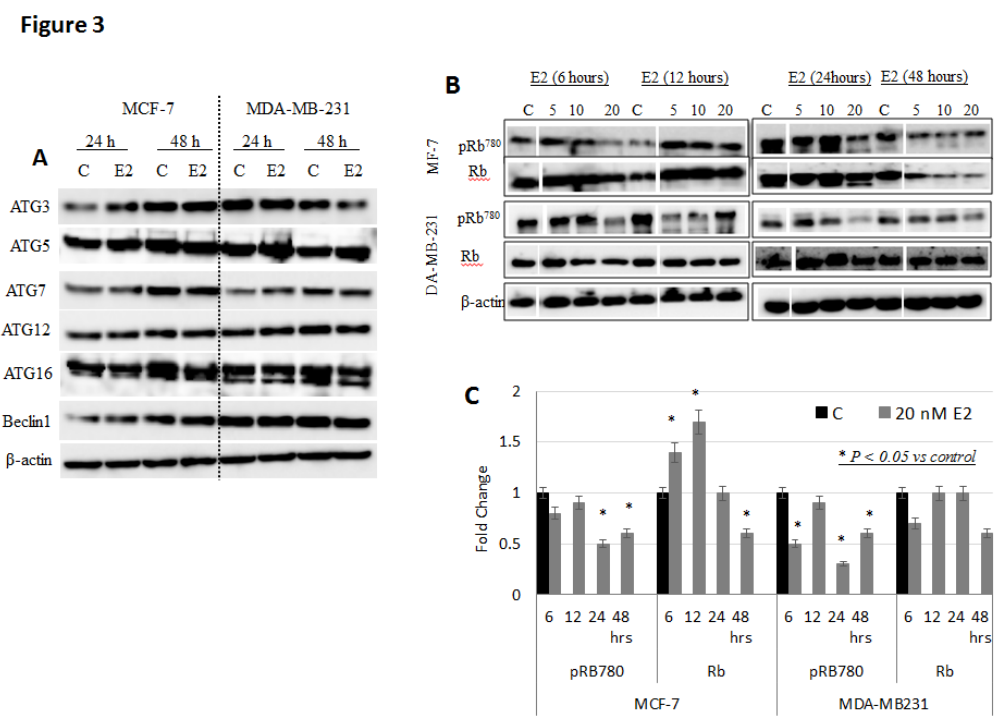
Figure 3. Expression pattern of autophagy-, cell cycle- and senescence-associated proteins in E2-treated MCF-7 cells. ( A ) Expression of autophagy related proteins ATG3, ATG5, ATG7, ATG12, ATG16, and Beclin1 in MCF-7 and MDA-MB-231 cells treated with 20 nM E2 for 24 and 48 hr. Data shown is representative of two separate experiments. ( B ) Expression of Rb and its phosphorylated form p-Rb780 was assessed by Western blotting in lysates of MCF-7 and MDA-MB-231 cells treated with 20 nM E2 for 6, 12, 24 or 48 h. ( C ) Mean + SD fold change in Rb and p-Rb780 expression levels in treated and untreated cells based on three separate experiments.